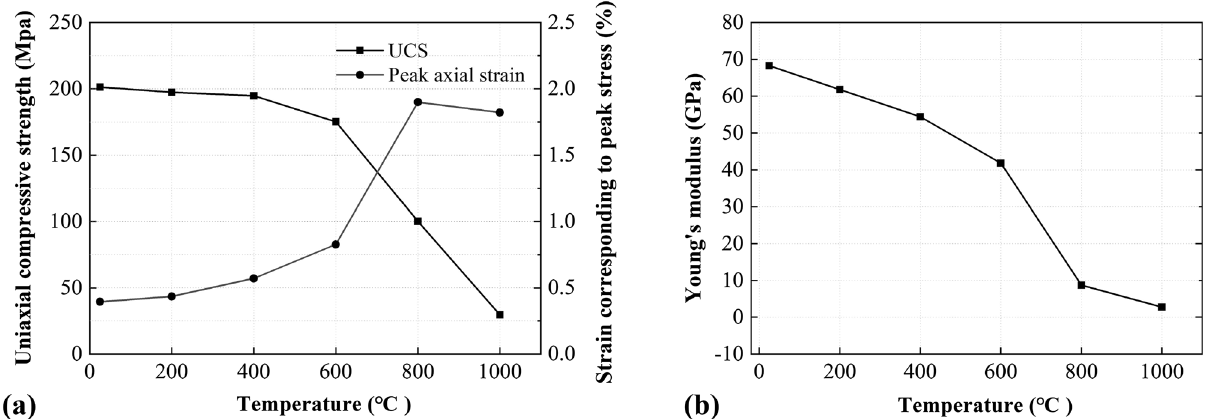
Figure 6. Effects of treating temperature on the mechanical properties of the marble samples: ( a ) uniaxial compressive strength and strain corresponding to peak stress, ( b ) Young’s